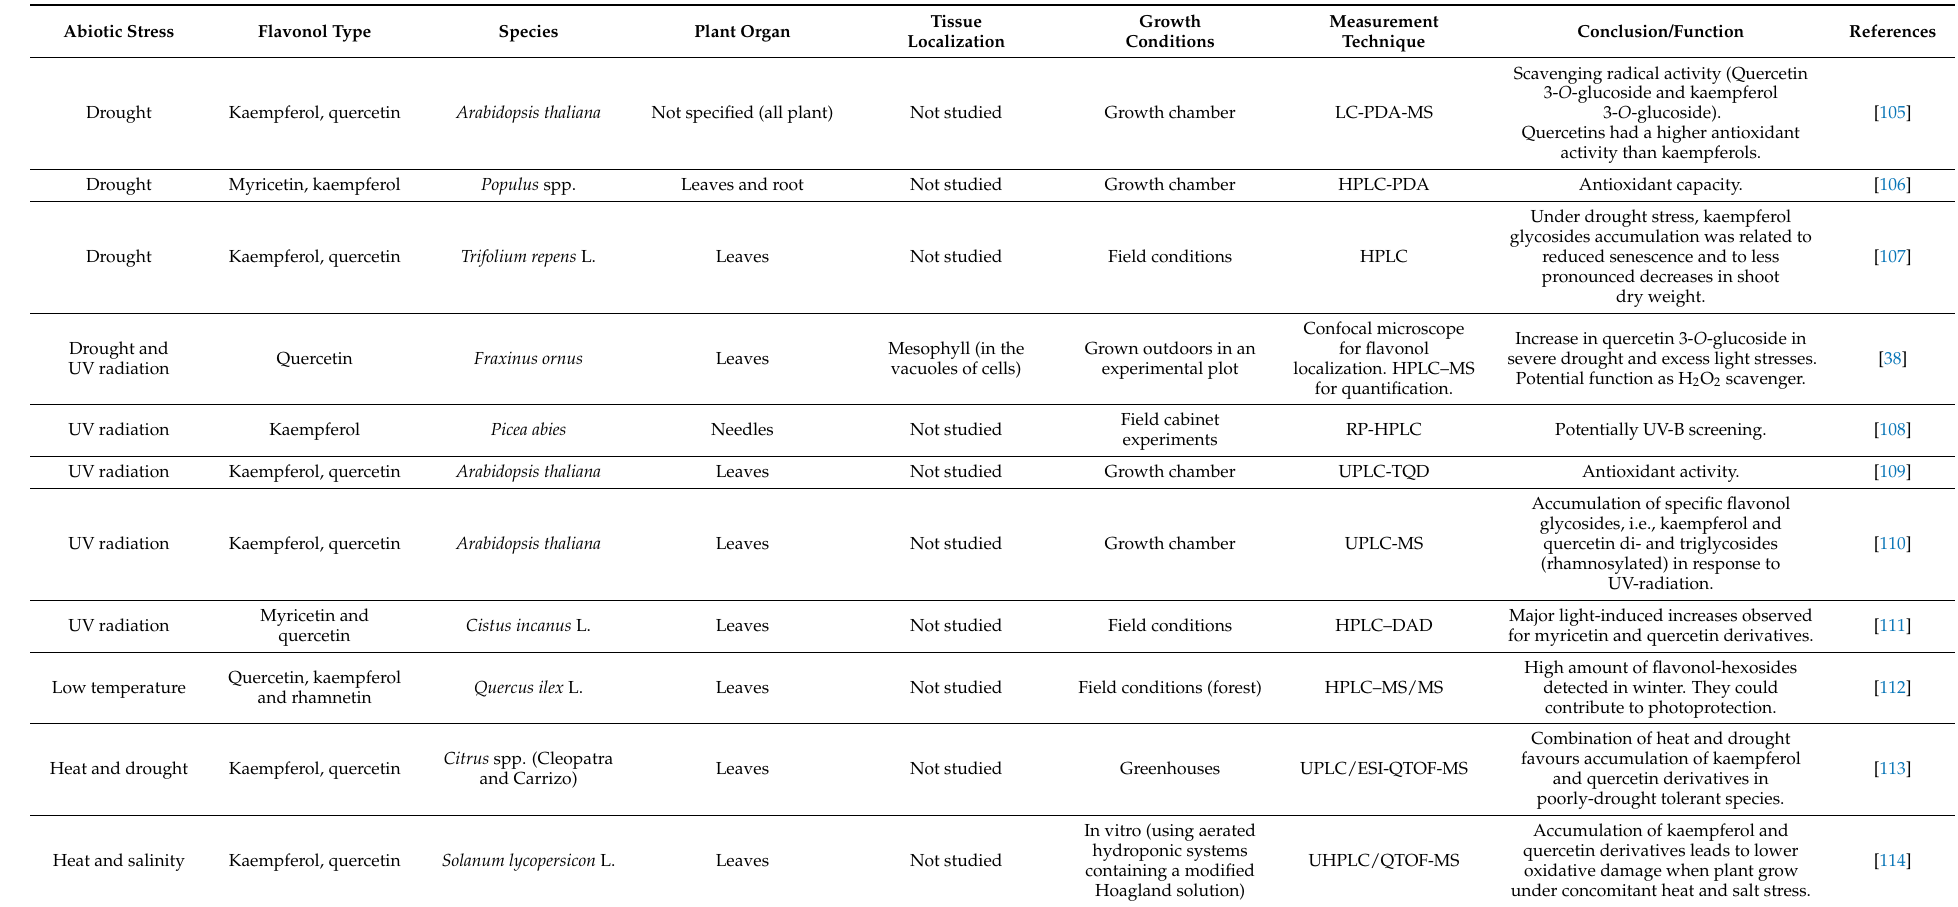
Table 2. Increasing of flavonol concentration under different abiotic stresses reported in literature for different species and experimental conditions. All studies are performed on harvested leaves or